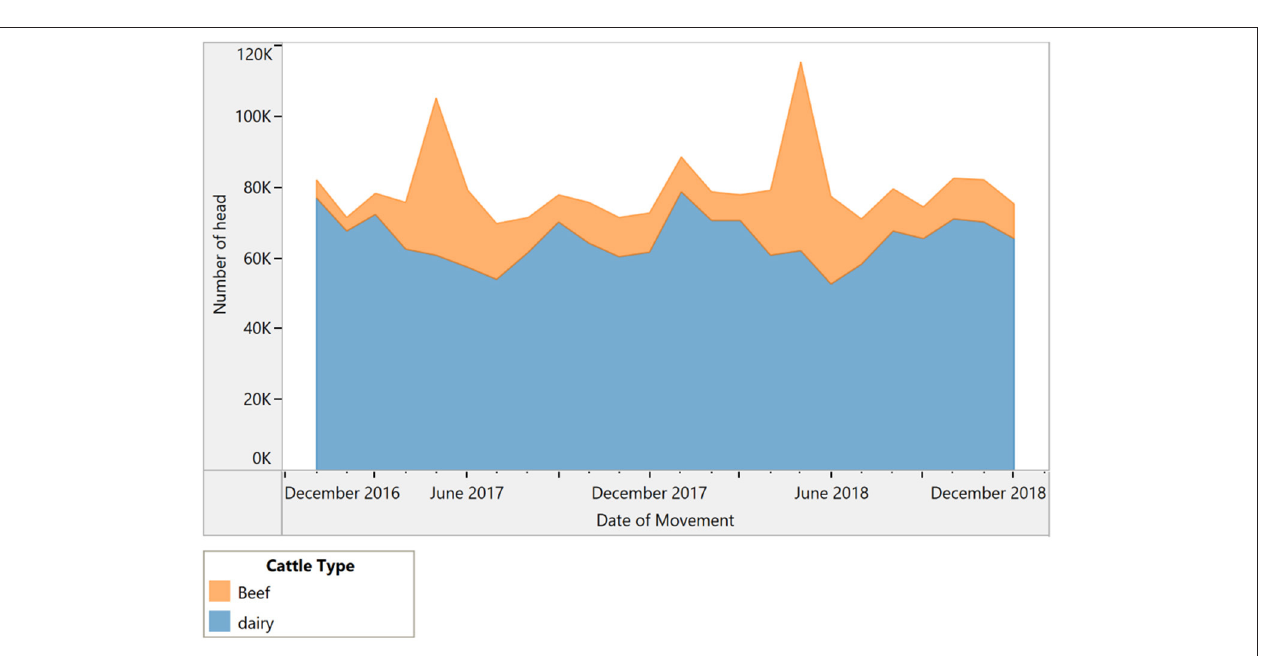
to processing, most frequently through a saleyard ( Table 2